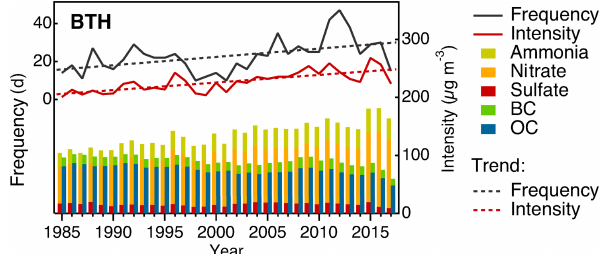
Figure 8. Simulated temporal variations in frequency (days, black line), intensity (µgm − 3 , red line), and concentrations of PM 2 . 5 components (µgm − 3 , bars): ammonia (blue), nitrate (yellow), sul- fate (red), black carbon (purple), and organic aerosols (green) of regional SWHDs in BTH from 1985 to 2017. Also shown are linear trends (dashed lines) for frequency and intensity, which are statisti- cally significant above the 95% confidence